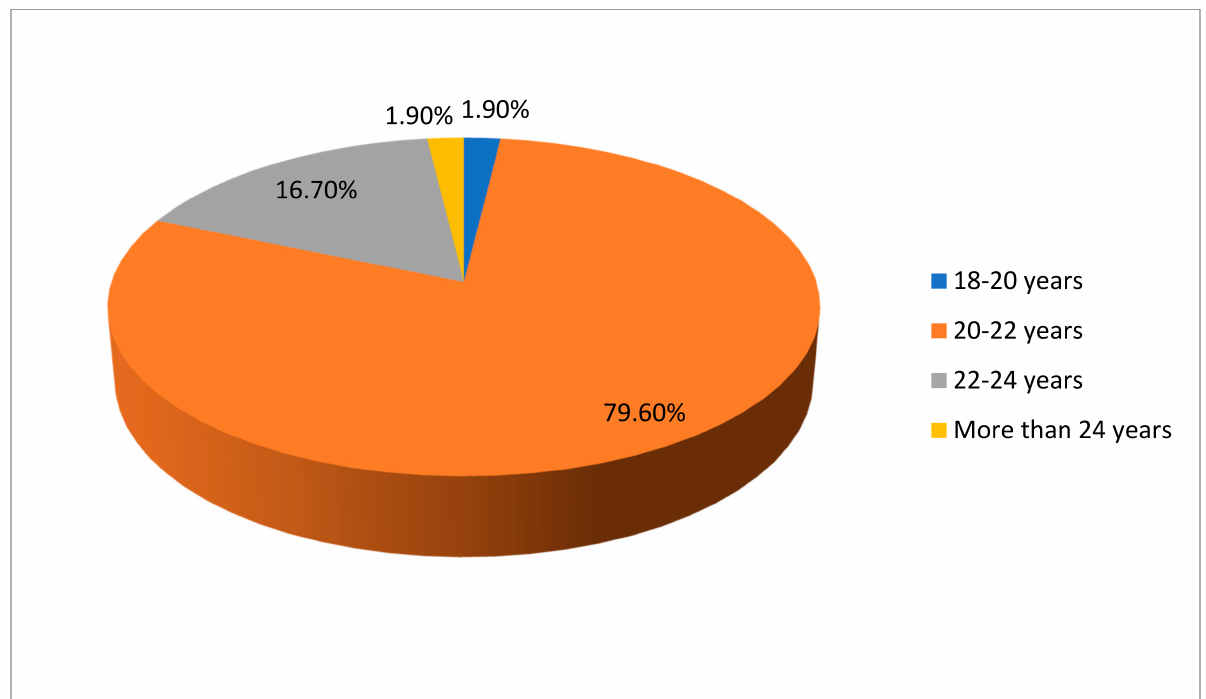
Figure 3. Percentages for age.